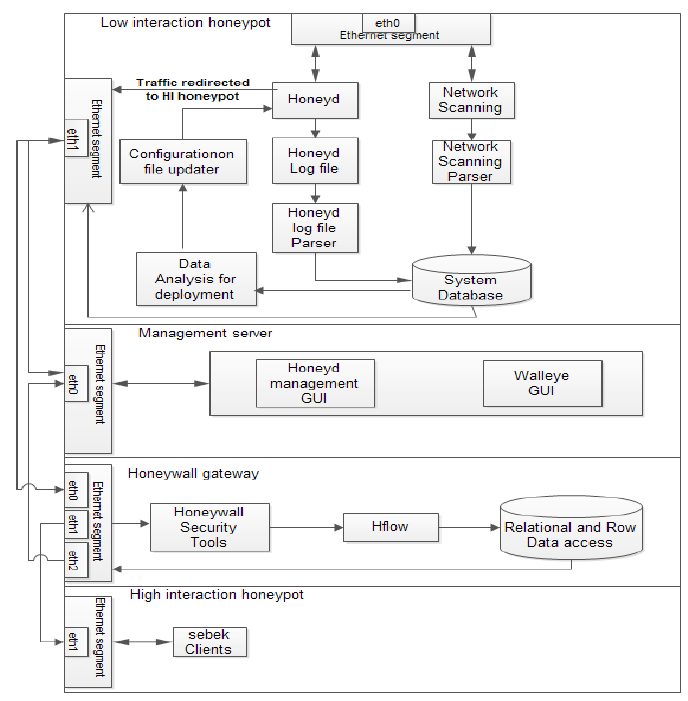
Fig. 5. Logical structure of proposed